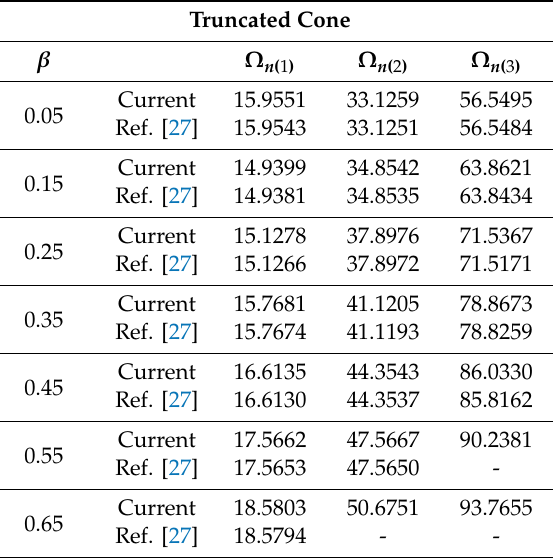
Table 3. First three dimensionless natural frequencies of a free-free truncated cone for di ff erent truncation factors, β with free-free boundary conditions.